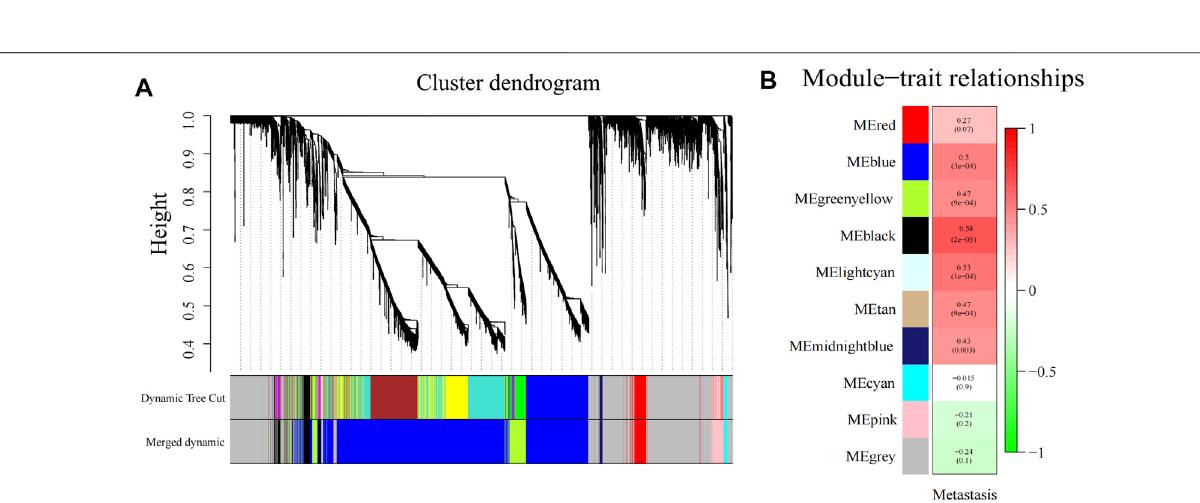
FIGURE3| VolcanoplotofDEGsinGSE14456. (A) DEGsbetweenlocalizedPDACpatientsandhealthydonors. (B) DEGsbetweenmetastaticPDACpatientsand healthy donors. PDAC, pancreatic ductal adenocarcinoma; DEGs, differentially expressed genes.